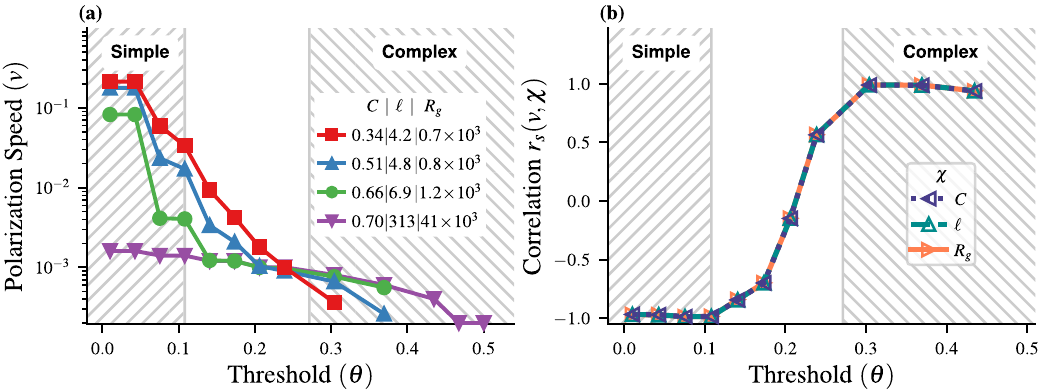
Fig. 1 Linear threshold model on WS networks of N = 10, 000 nodes, with fi xed average degree 〈 k 〉 = 16 and uniform threshold θ . Initially, a single randomly selected seed node and its neighbors are activated. a Average polarization speed v when the cascade size is 30% active nodes on the network, with lines stopping prematurely if the fraction is never reached, shown for a representative set of network metrics (Supplementary Fig. S1 for other cascade sizes). The WS rewiring probability p is used to generate network samples having speci fi c values of χ ∈ { C , ℓ , R g }. b Spearman ’ s correlation coef fi cients r s between the polarization speed v and each network property χ ∈ { C , ℓ , R